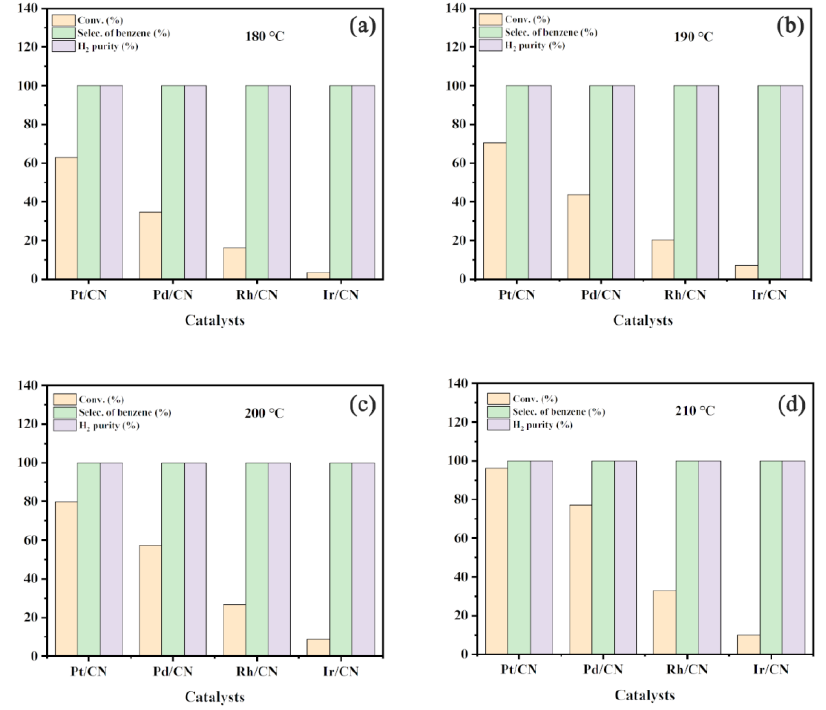
Figure 5. Cyclohexane conversions, selectivities of benzene and H 2 purities with M/CN (M = Pt, Pd, Rh and Ir) catalysts at ( a ) 180 °C, ( b ) 190 °C, ( c ) 200 °C and ( d ) 210 °C.